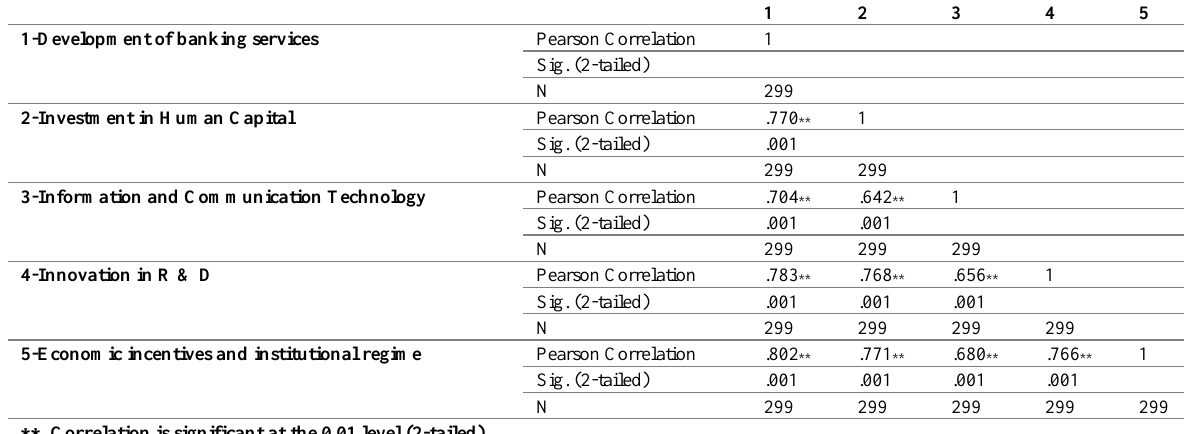
Table 4: Correlations Between Main Variables of Knowledge Economy and The Development of Banking